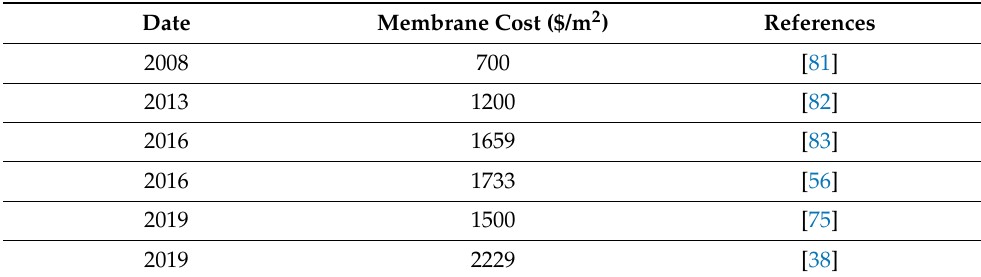
Table 2. Nafion ® 117 cost